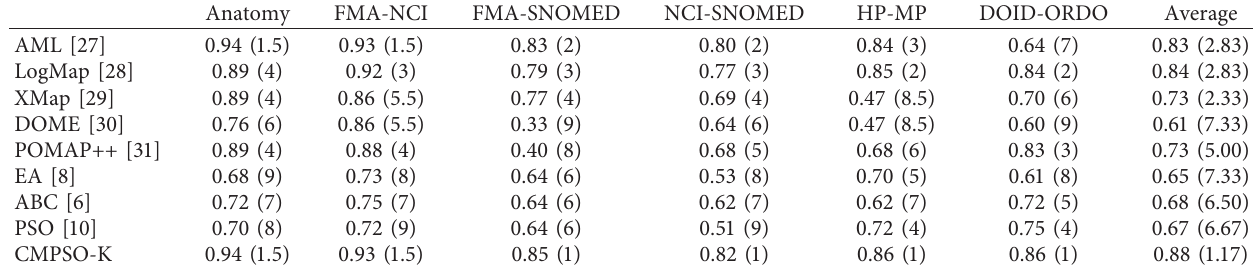
Table 2: Friedman’s test on the alignment’s quality. Each value represents the f-measure, and the number in round parentheses is the corresponding computed rank.